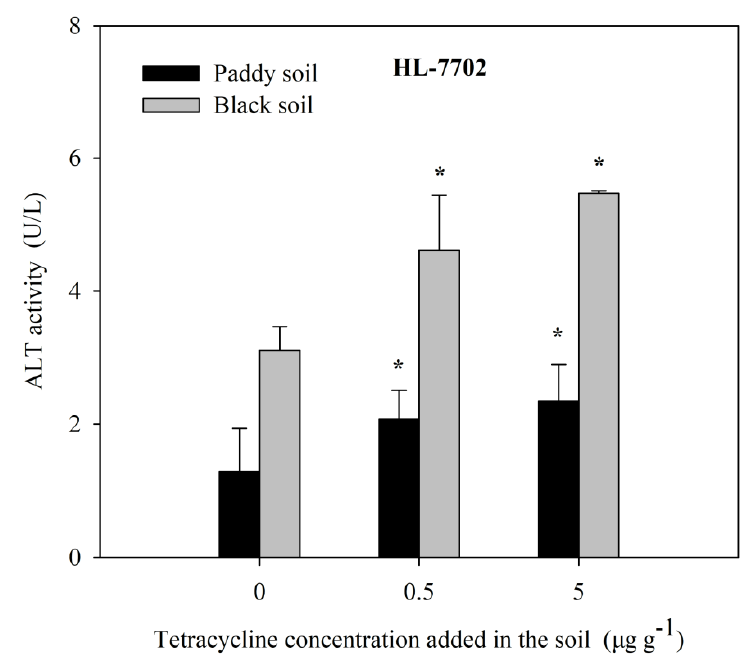
Figure 6. The effects of soil TC on the ALT activity in HL-7707 cells. Data are given as mean ± S.E. ( n = 3); “*” indicate significant ( p < 0.05) differences between controls ( 0 μg L – 1 TC) and treatments.